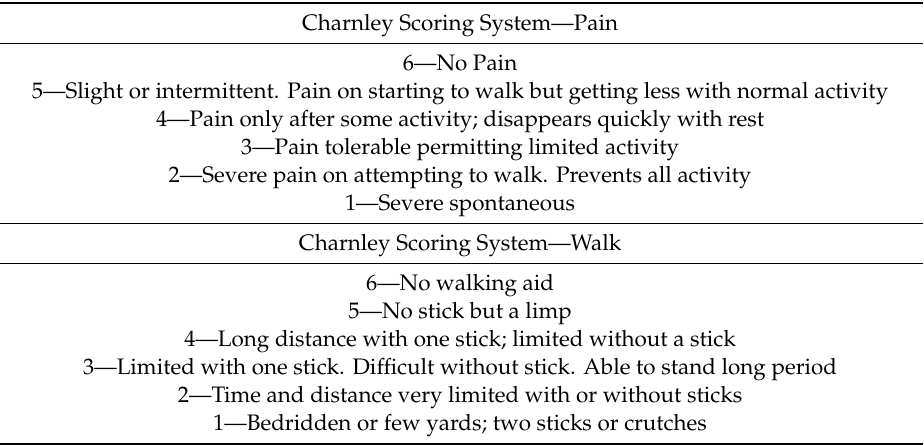
Table 1. Charnley’s modified pain and mobility scoring